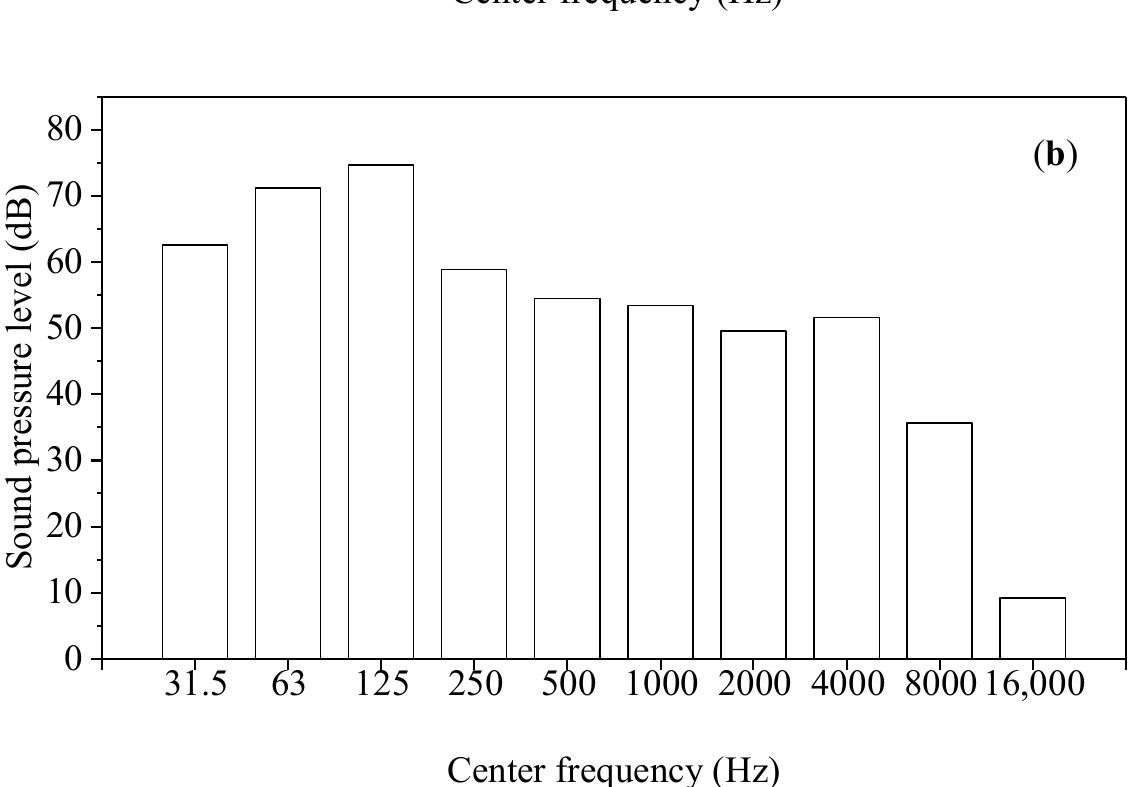
Figure 1. A 1/1 octave band spectra of two typical noise samples ( a ) 500 kV substation noise ( b ) 1000 kV substation noise.